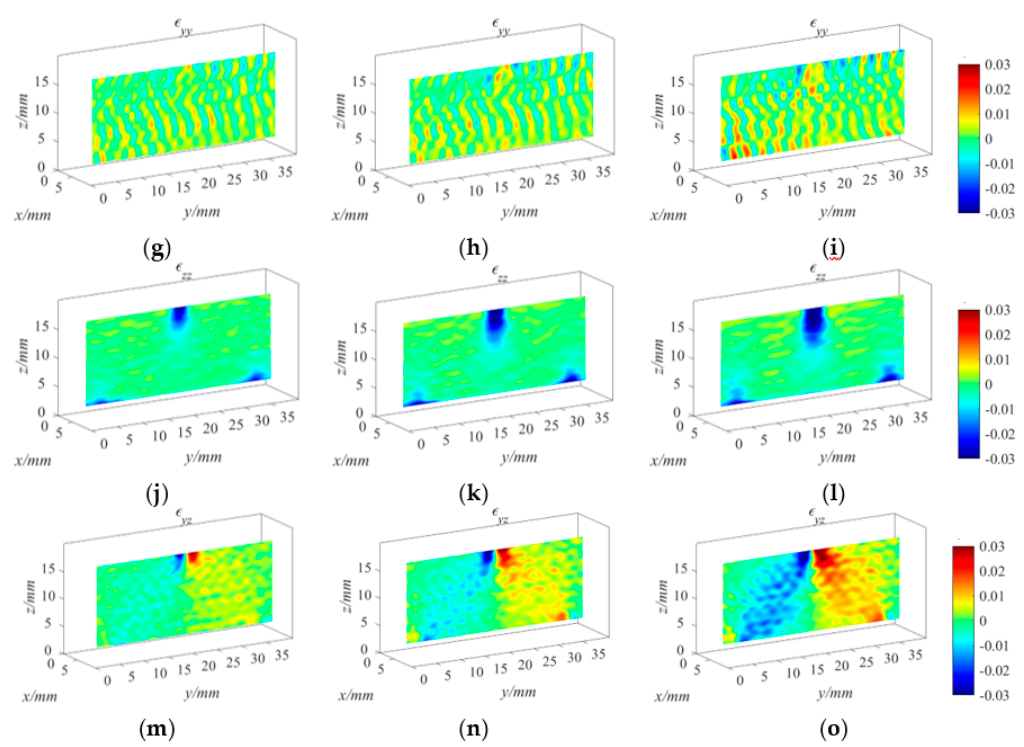
Figure 10. Displacement and strain fields of the middle longitudinal sectional image at step 7, step 9 and step 10, respectively; ( a – c ) v fields; ( d – f ) w fields; ( g – i ) ε yy fields; ( j – l ) ε zz fields; ( m – o ) ε yz fields.